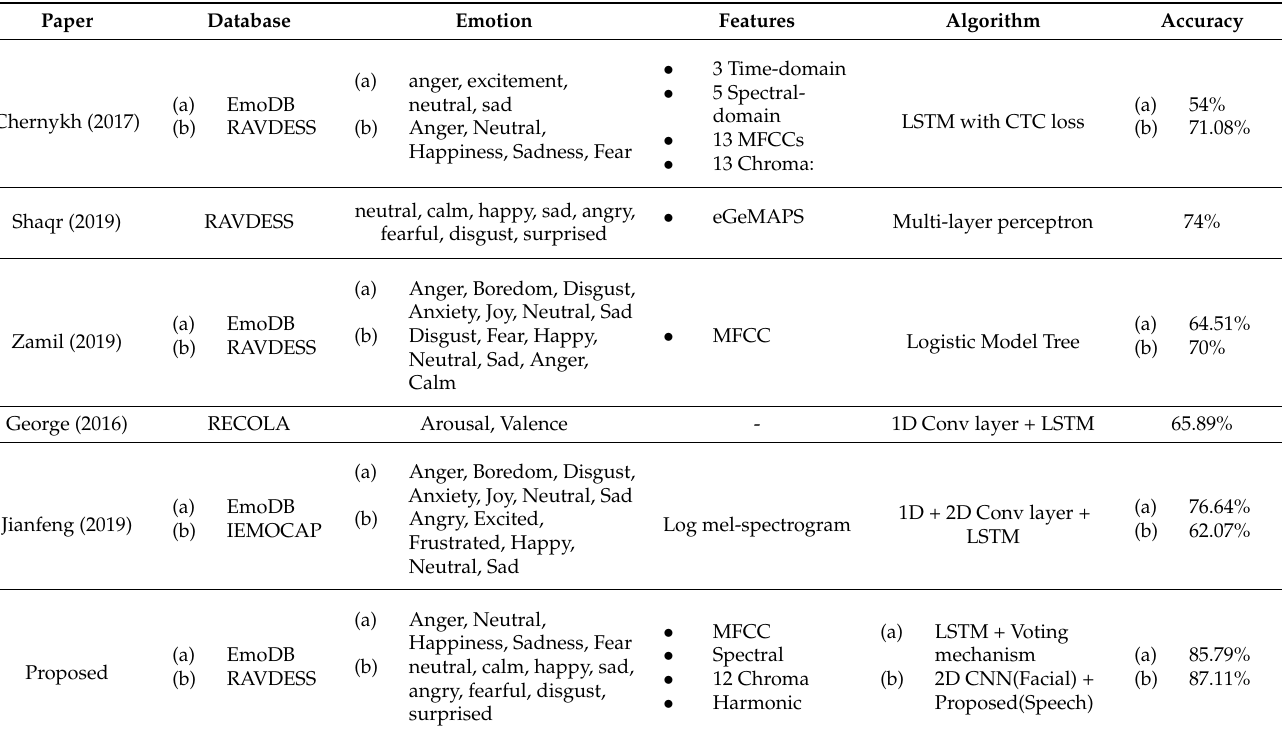
Table 4. Experimental results from International